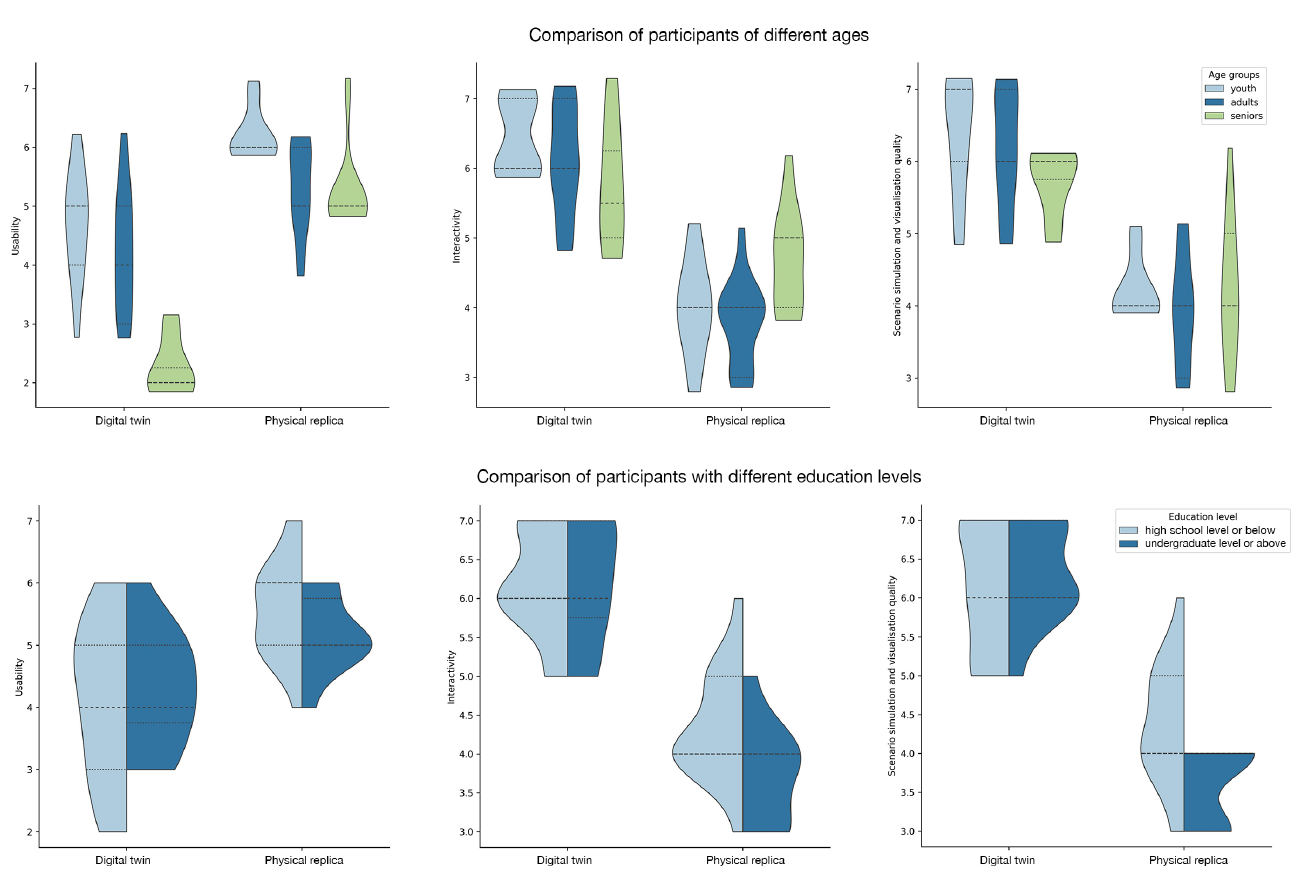
Figure 6. Comparison of the distribution of three evaluation indicators among participants’ ages (youth: 18 years old and below; adults: 18–59; seniors: 60 and above) and education levels (high school level or below and undergraduate level or above) on digital twin and physical